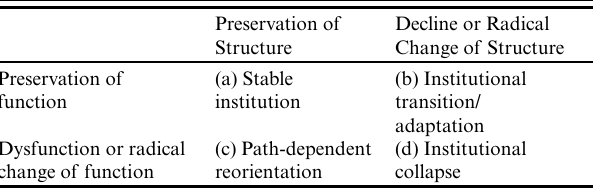
Table 1 . Typology of institutional change with respect to preservation or collapse of structure and function (source: Newig